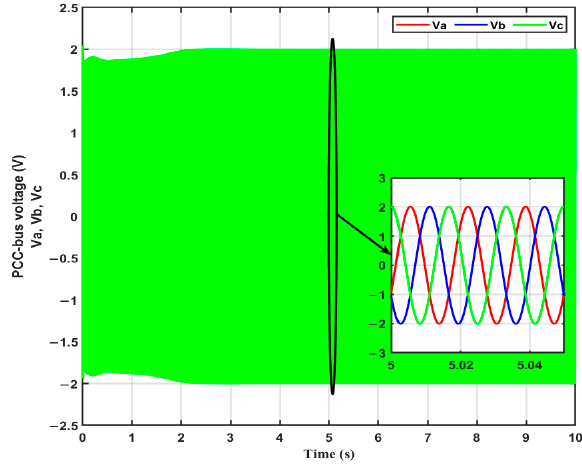
Figure 19. Voltage of PCC bus.